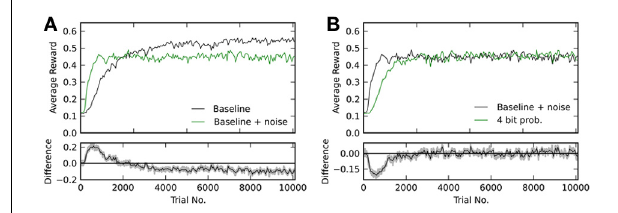
FIGURE 7 | Histograms of synaptic weights after learning. The weights from all 20 repetitions for each resolution and update mode are shown. (A) Continuous weights. (B) 8bit weights in black. Continuous weights are discretized to this resolution and shown in green. (C) 6bit weights in black, again with equally binned continuous weights in green. (D) 4bit weights with